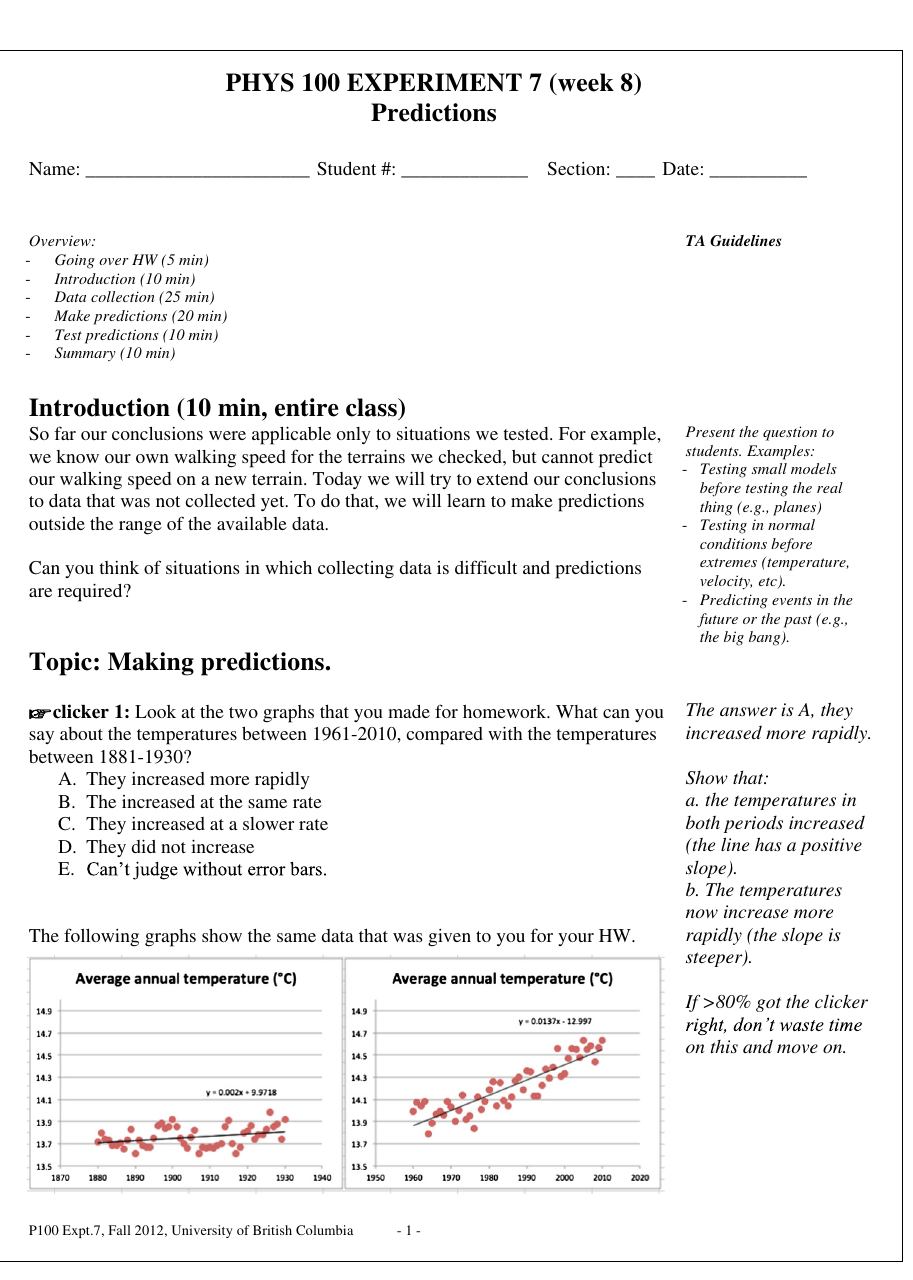
FIG. 4. Page 1 of the TA version of the lab